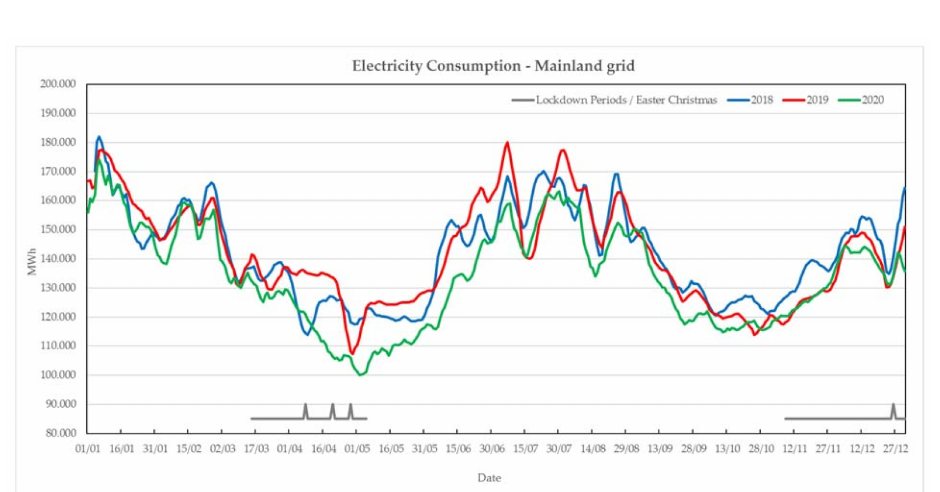
Figure 3. Daily 7-day running averages for the electricity consumption in the mainland of Greece for 2019, 2018, and 2020, adjusted for temperature (MWh). The lockdown periods and the Orthodox Easter are also